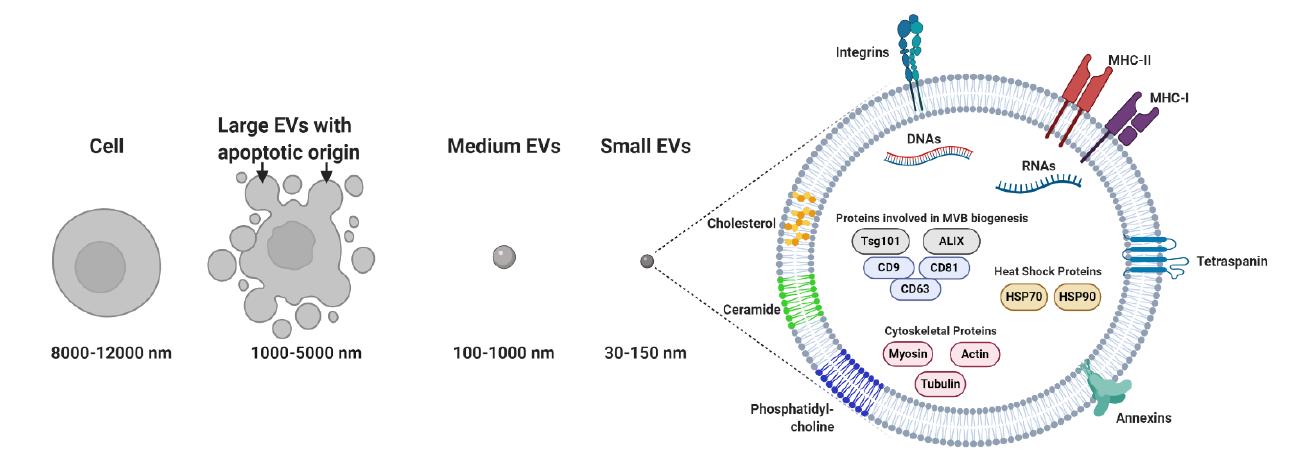
Figure 1. Sizes of most common cell particles: small extracellular vesicles (EVs) are 30 nm to 150 nm in size, and medium- sized EVs are in the 100 nm to 1000 nm range, while large EVs of apoptotic origin are typically 50 nm to 5000 nm in diameter [11]. The release of small EVs or exosomes differs from migracytosis, which involves the translocation of cytoplasmic material to migrasomes, followed by their release when the retraction fibers break [12]. In addition, the uptake of small EVs may have an effect on recipient cells different from that of multivesicular body (MVB)-like EVs, whose release may lead to a relatively delayed effect on the microenvironment [13]. Molecular composition of exosomes: exosomes are surrounded by a phospholipid bilayer and contain numerous molecules, including proteins, lipids, DNA and several types of RNA. (MHC: major histocompatibility complex).